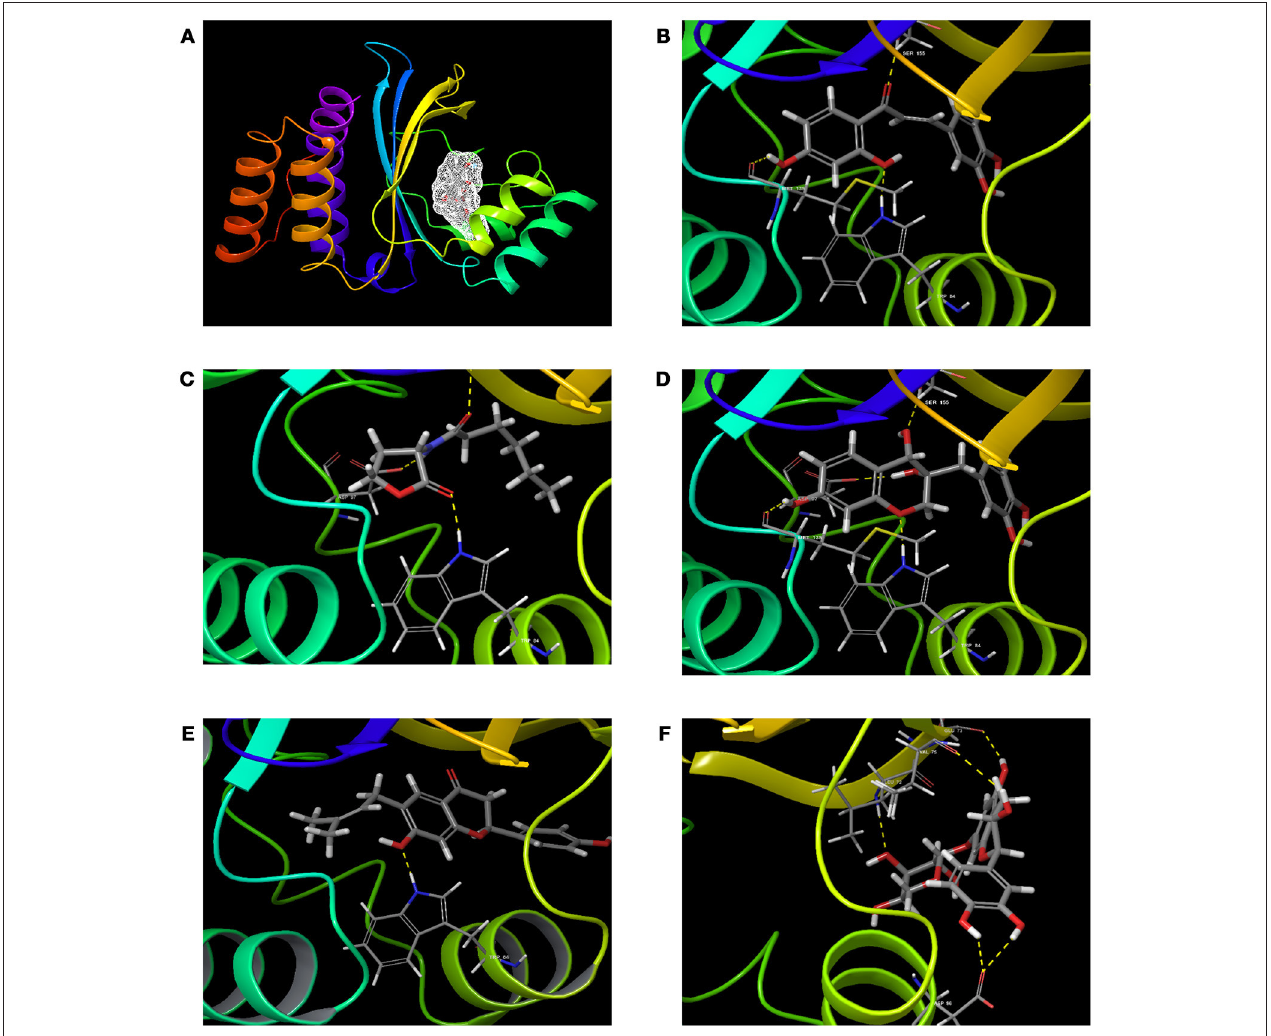
FIGURE 2 | The 3D molecular interactions of QSIs against CviR (A) is for CviR, the LuxR homolog of C. violaceum where the ligand binding pocket is depicted in light gray (B) is for molecular interaction of C 6 HSL with CviR (3H bonds) (C) for molecular interaction of SPL (4H bonds) (D) for molecular interaction of BN1 (3H bonds) (E) for molecular interaction of BN2 (1H bond) and (F) for molecular interaction of C7X against CviR (4H Bonds). H-bonds represented in yellow dotted line.